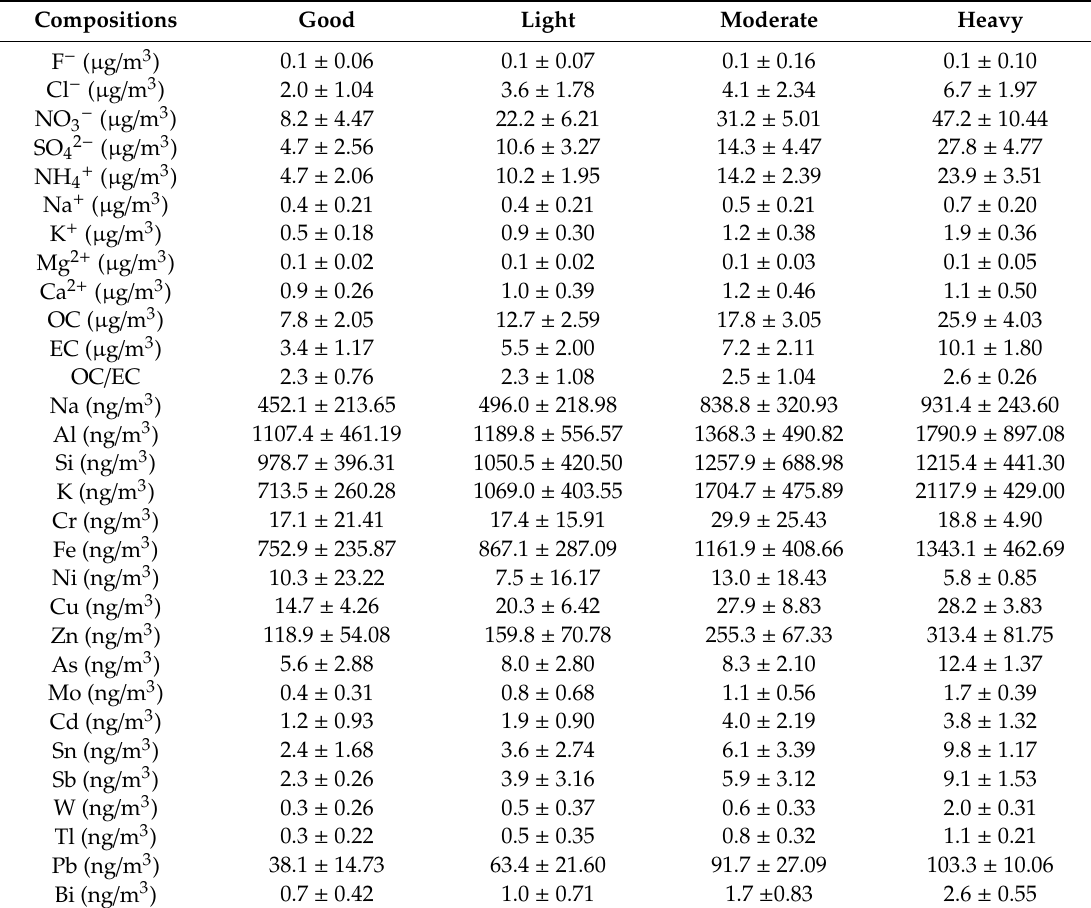
Table 2. Mass concentration of major compositions in PM 2.5 in di ff erent pollution days.